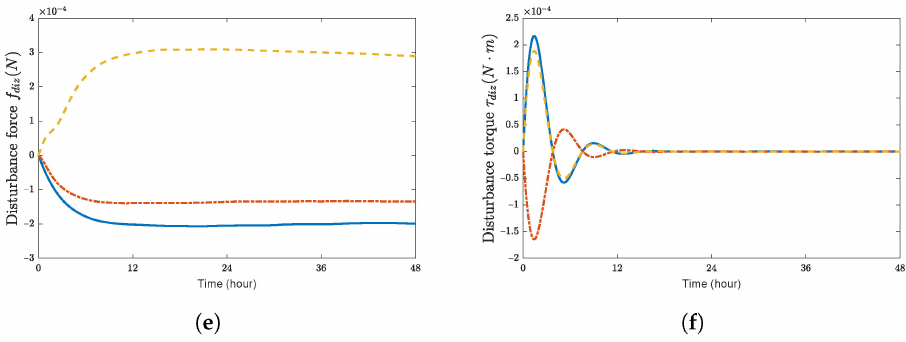
Figure 7. Disturbance forces and disturbance torques of spacecraft SC1 ∼ 3 with adaptive control